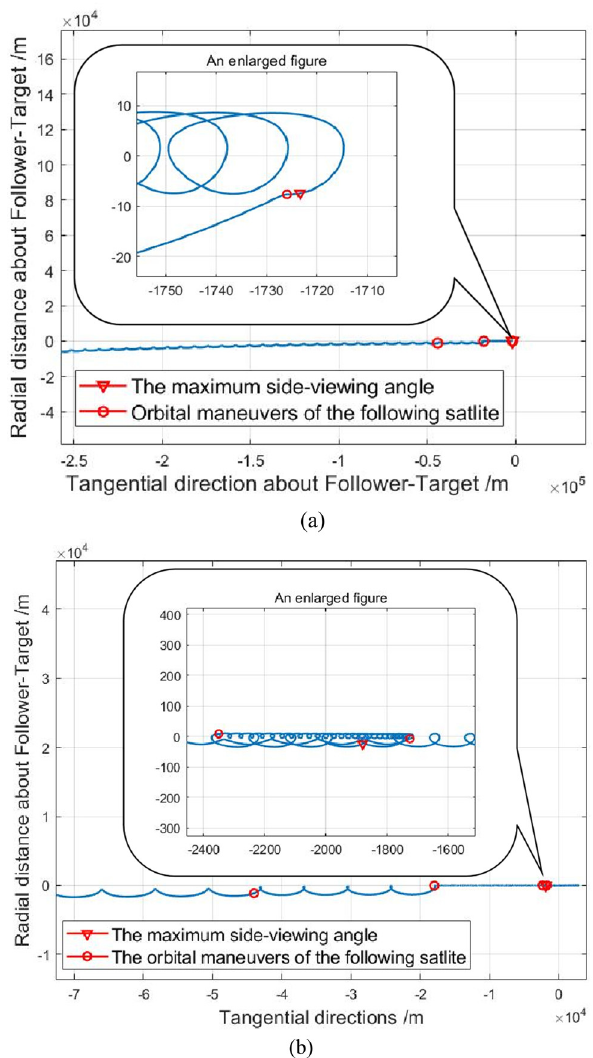
Figure 6: Variation in the in - plane relative distance of two satellites caused by ( a ) ascending orbit and ( b ) descending orbit during the hold control system